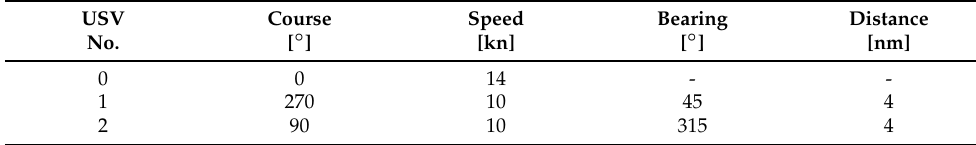
Table 8. Input data of test case